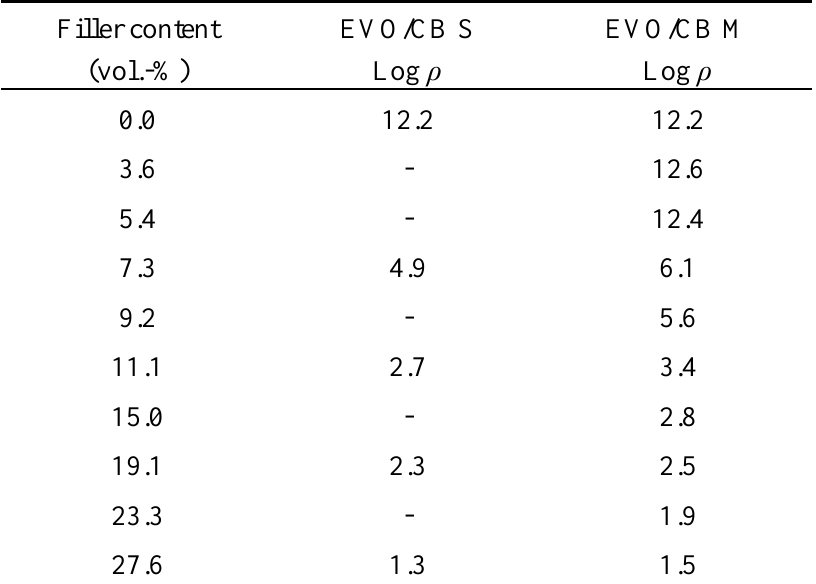
Table 3 . Electrical resistivity of EVO/CB S and EVO/CB M composites with various filler contents ( ρ in Ω